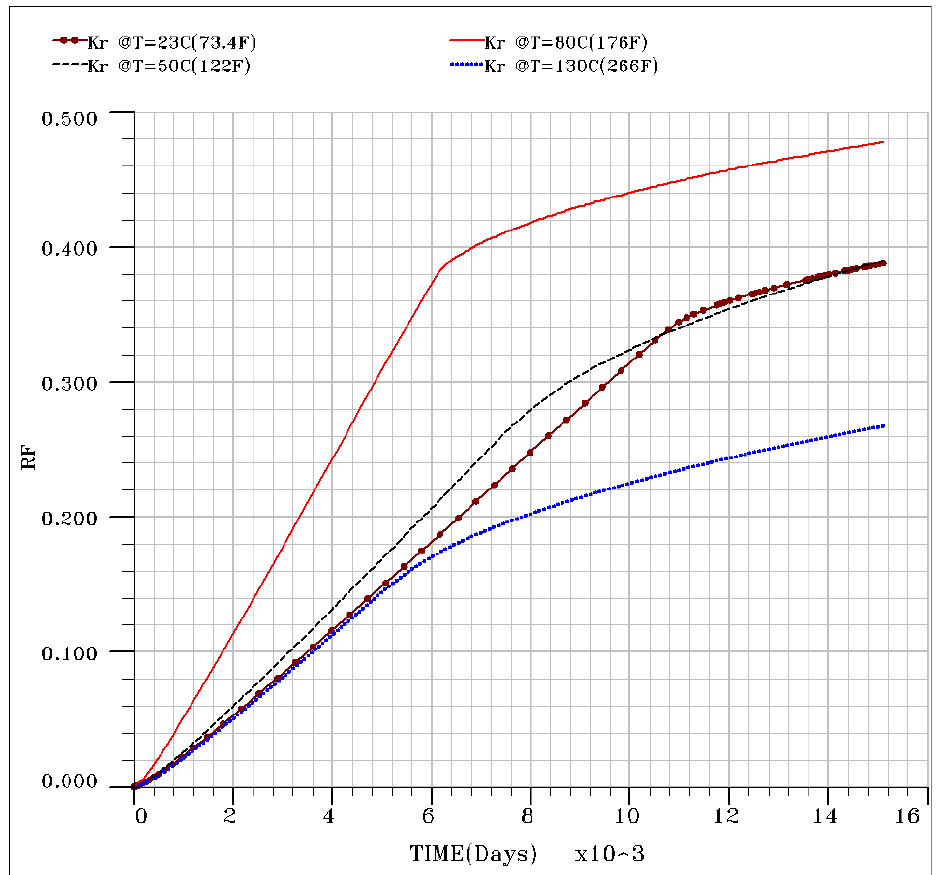
Figure 3. Simulated oil recovery factor as a function of relative permeability at 23, 50, 80 and 130 o